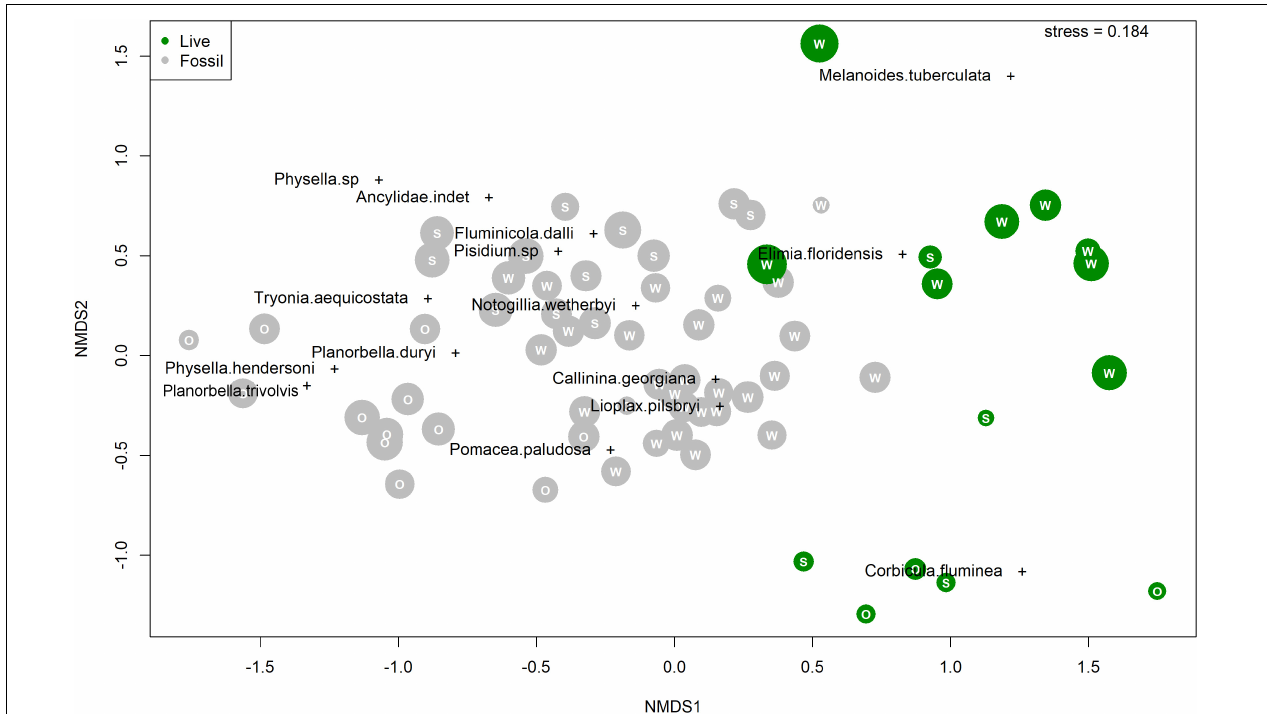
FIGURE 5 | Non-metric Multidimensional Scaling (nMDS) species and sample scores. Fossil samples in gray and live samples in green. Letters correspond to a sample’s river system: “W” for Wakulla, “S” for Silver, and “O” for Ocklawaha. Points scaled by number of specimens in each sample.